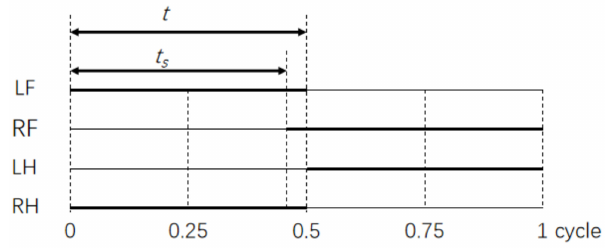
Figure 4. The soar period of the actual diagonal